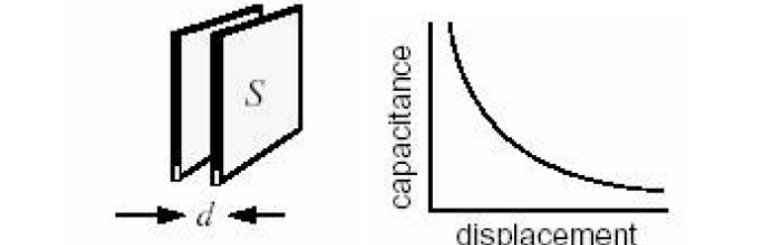
Figure 3. Parallel plate capacitance configuration and capacitance vs. displacement